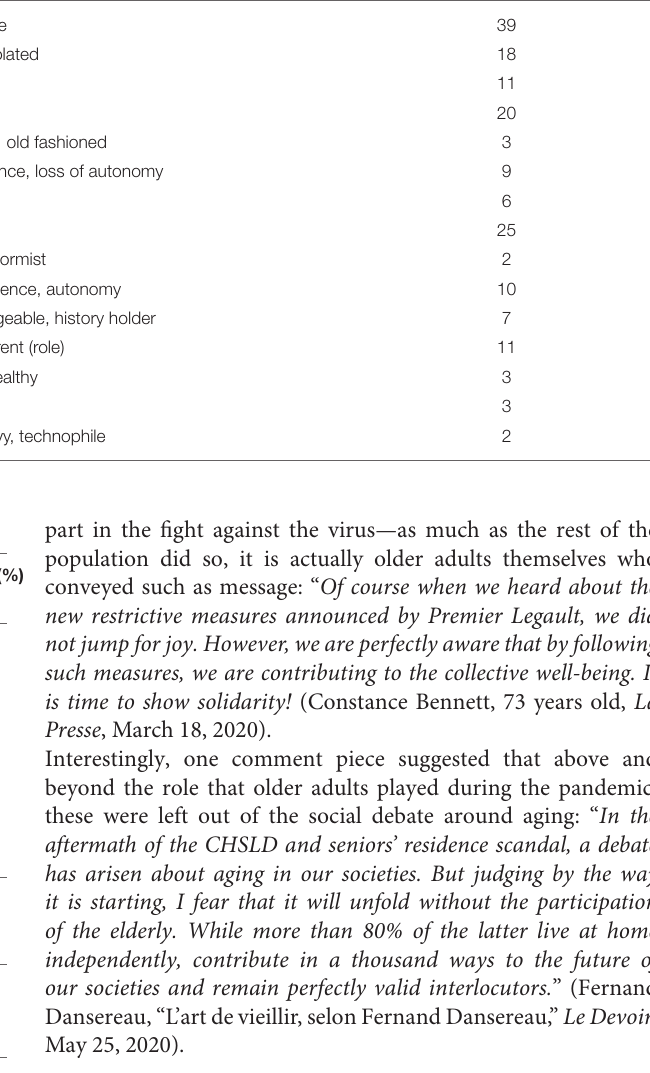
TABLE 1 | Frequency of keywords associated with older people. Connotation of terms (positive, negative, or both) Terms used to describe older adults